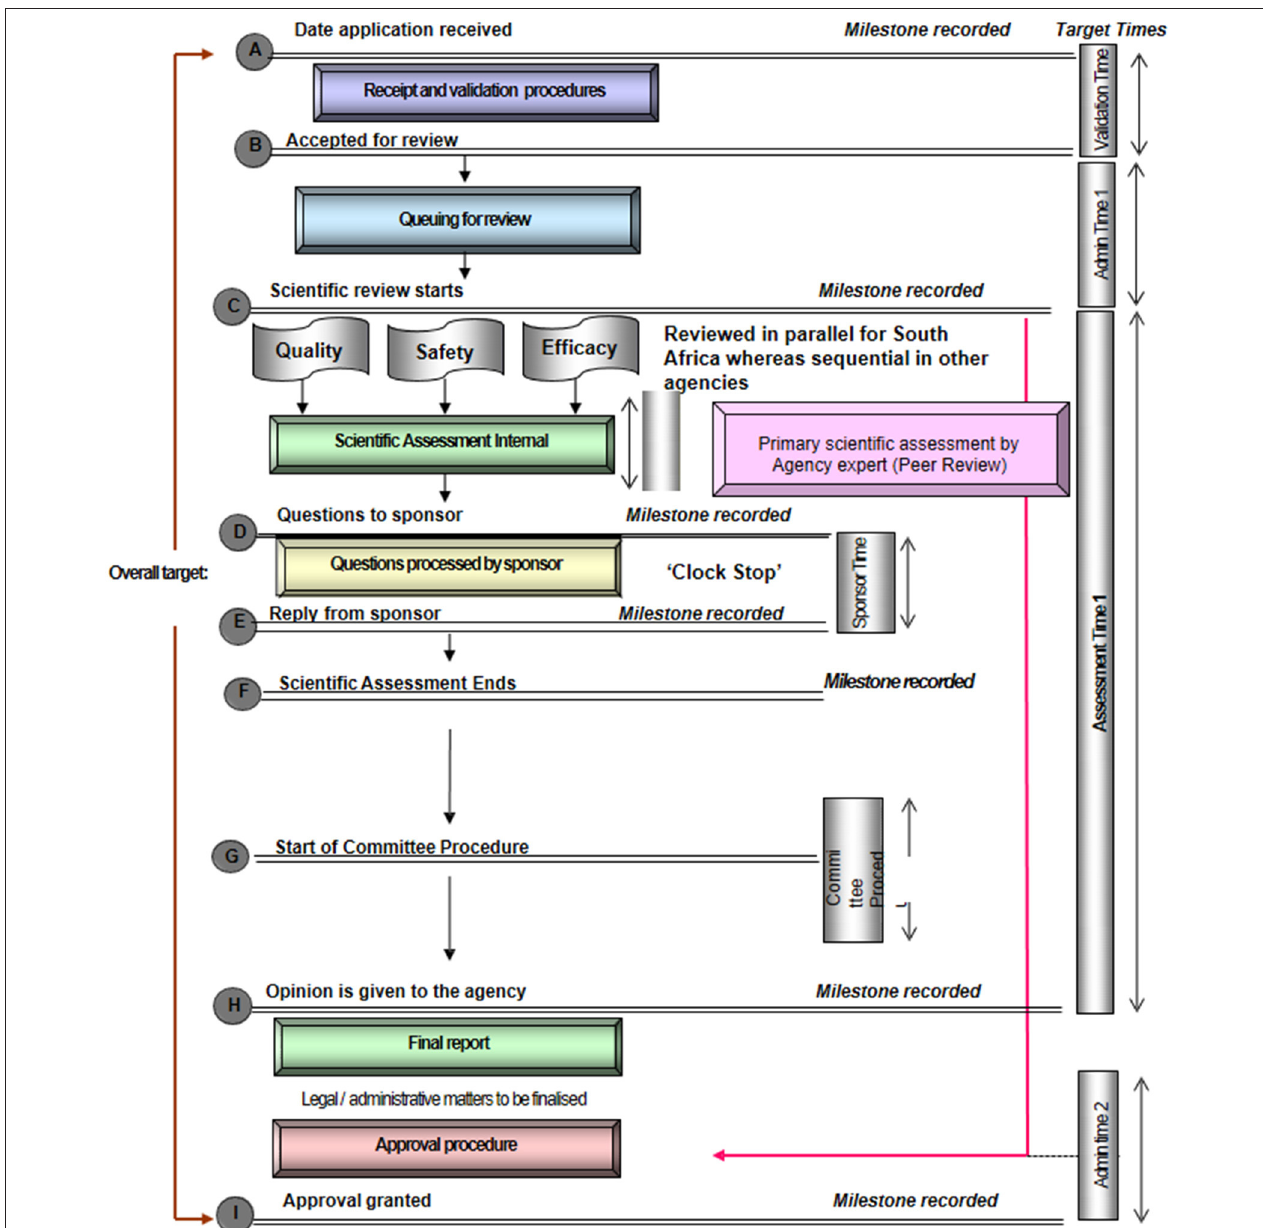
FIGURE 1 | Standardised review process map for regulatory agencies. This map represents the review and authorization of a product that goes to approval after one review cycle. It should be noted that in some countries milestone G (committee procedure) may come before milestone D (questions to the